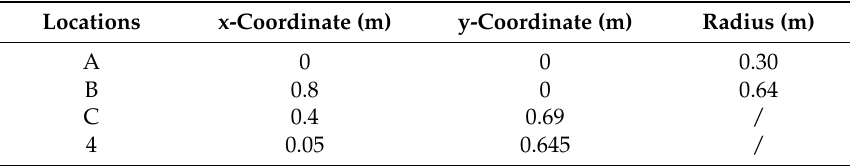
Table 8. Initial data of the fourth case study.